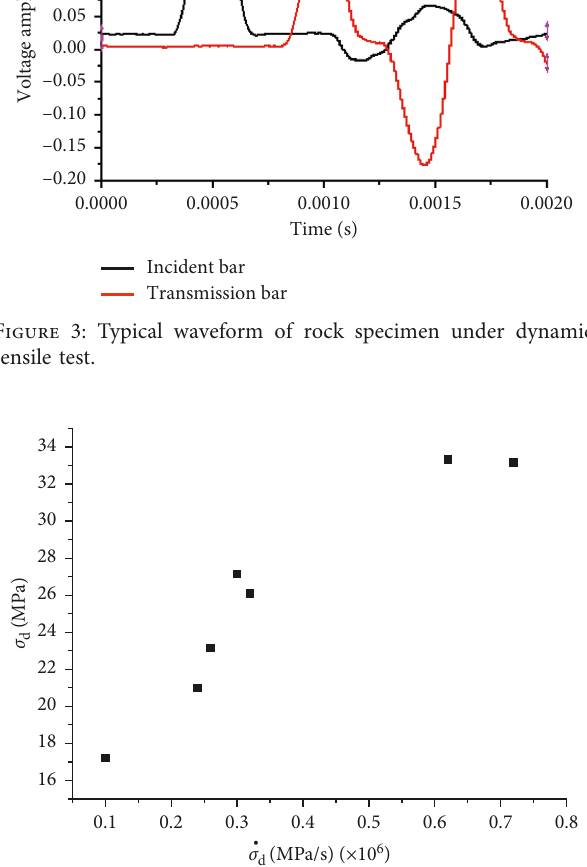
Figure 7: Relationship between dynamic tension strength and loading rate at depth 420m.